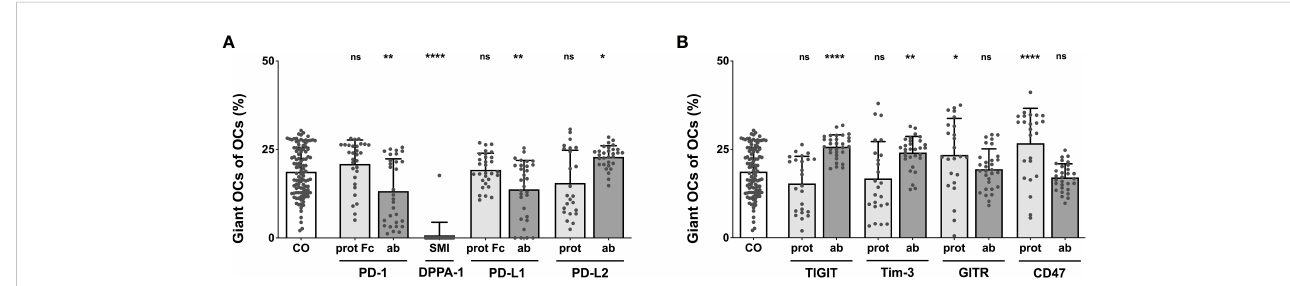
FIGURE 4 Analysis of the percentage of giant OCs that make up total OC numbers. Giant OCs make up a signi fi cant proportion of total OC. As all inductions are well below 50%, alterations in total OC number are mostly due to changes in the number of small OCs. (A) Group of PD-1-related checkpoint molecules. (B) Group of checkpoint molecules that are not yet approved for clinical use. Each data point represents the percentage of giant OCs of the total OC number, analyzed in a square of 1 mm 2 , of which 6 were assessed per culture well. Columns show mean and standard deviation. Asterisks indicate level of signi fi cance in comparison to CO, set at P < 0.05 (* < 0.05, ** < 0.01, **** < 0.0001; ns, non-signi fi cant). All data is acquired from at least 3 independent experiments, each with a minimum of 2